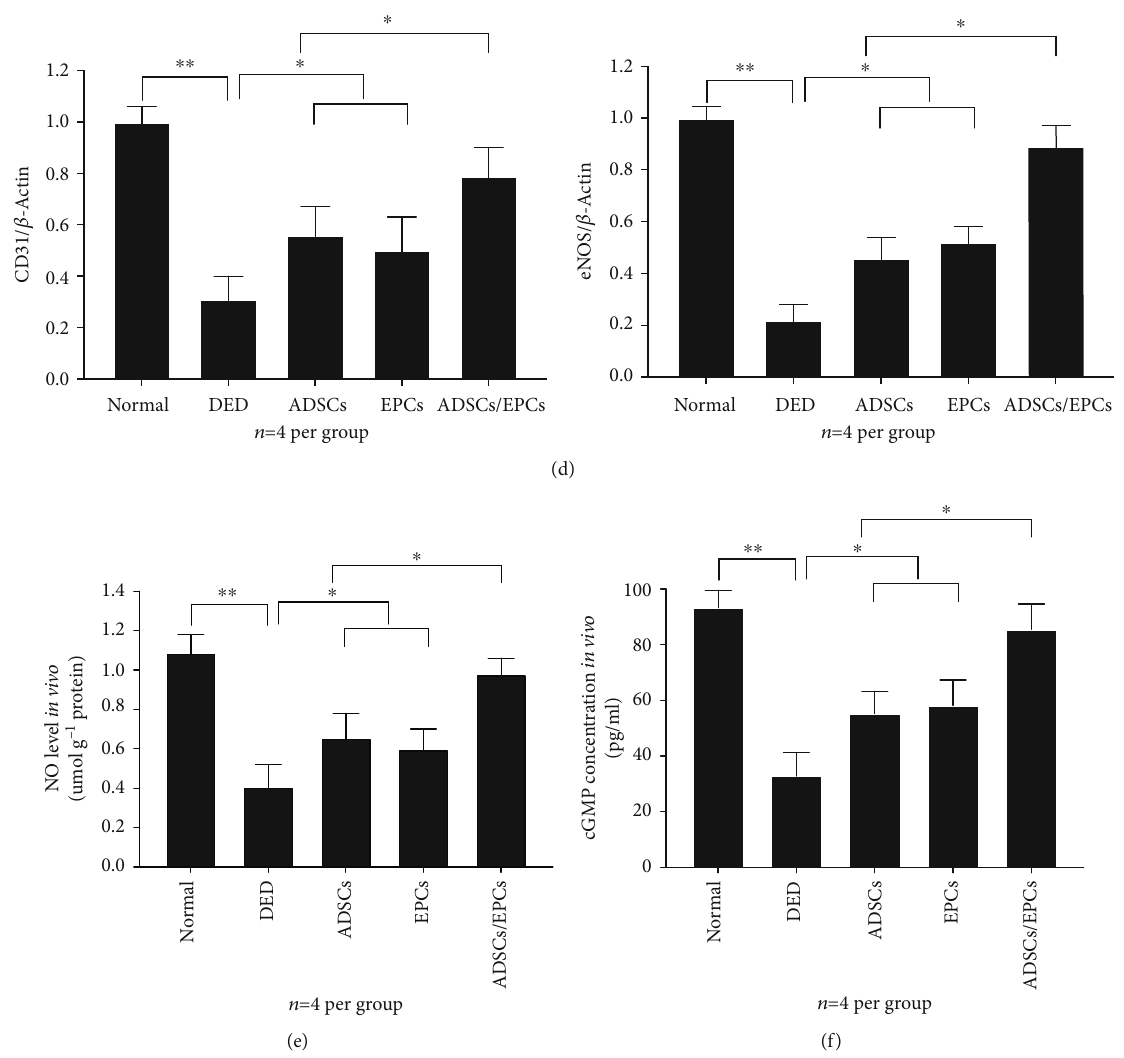
Figure 4: Combined transplantation of ADSCs and EPCs improved the endothelial function of DED rats. (a) Immuno fl uorescence staining of CD31 (green) and EdU (red) in the cavernous tissue in each group. The white arrow shows the transplanted EPCs. Scale bar: 100 μ m. (b) Immuno fl uorescence staining of eNOS (red) in the cavernous tissue in each group. Scale bar: 50 μ m (c, d) The representative images and quantity analysis of western blotting, including CD31 and eNOS. Data is expressed as relative expression compared to β -actin and to the normal group. (e) NO level in the serum of each group determined by ELISA assay. (f) cGMP concentration in the cavernous tissue in each group was determined by ELISA. ∗∗ p < 0 : 01 , ∗ p < 0 : 05 . EdU: 5-ethynyl-2 ′ -deoxyuridine; eNOS: endothelial nitric oxide synthase; NO: nitric oxide; cGMP: cyclic guanosine